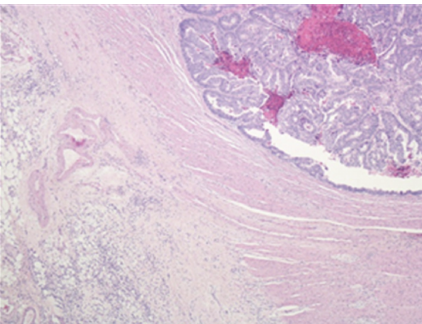
Figure 1: Low power light microscopy image demonstrating well- differentiated adenocarcinoma (upper right of image) and small noncohesive cells with the appearance of metastatic infiltration (lower left of image).